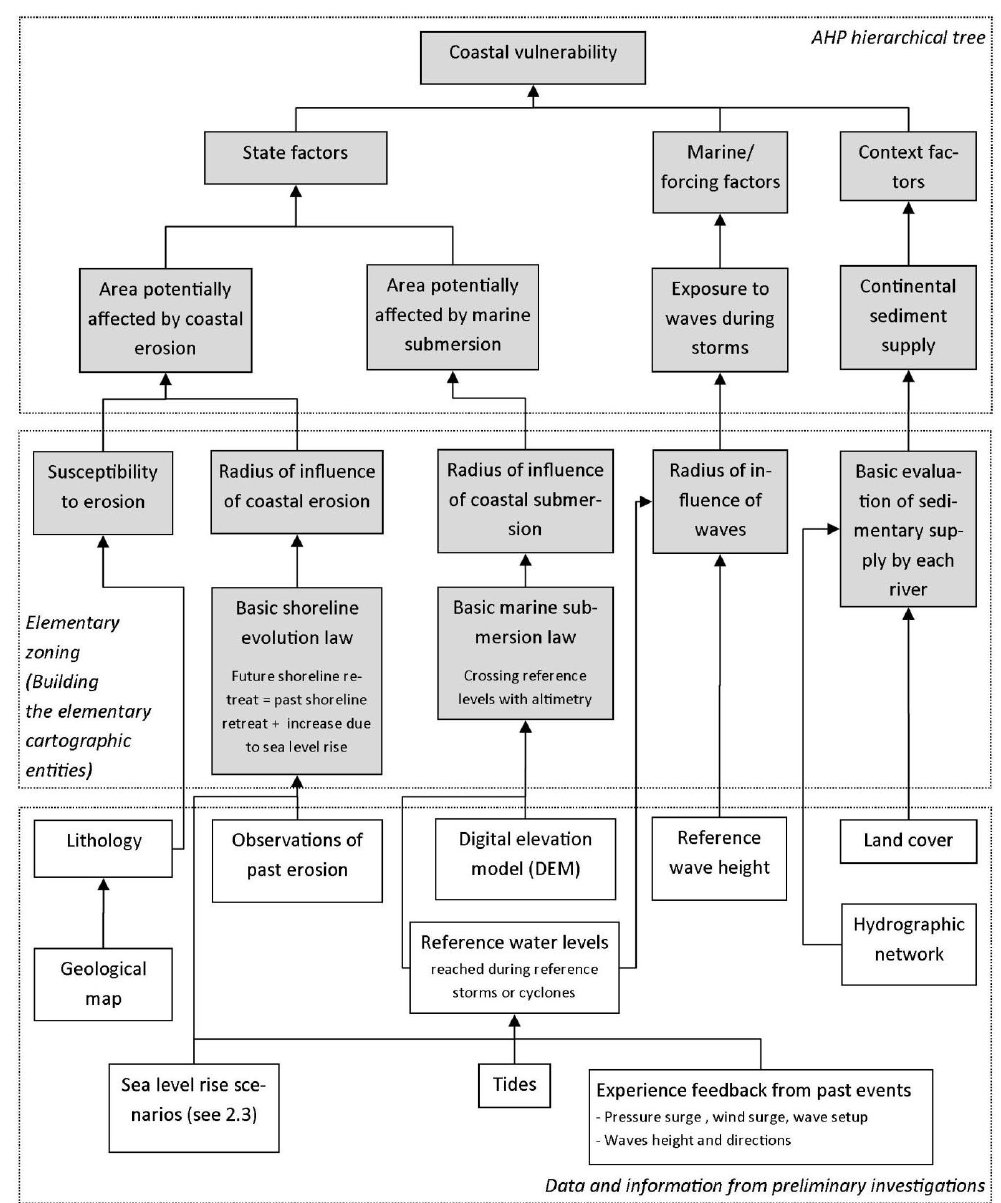
Fig. 3. Hierarchical tree and related elementary zoning used for the “sea level rise” scenario in Languedoc-Roussillon. A very similar tree was used for La R´eunion (see Table 5 for a comparison of the two sites). In practice, most of the geoprocessing work consisted of defining elementary geographical spatial entities and rating them for each criterion.